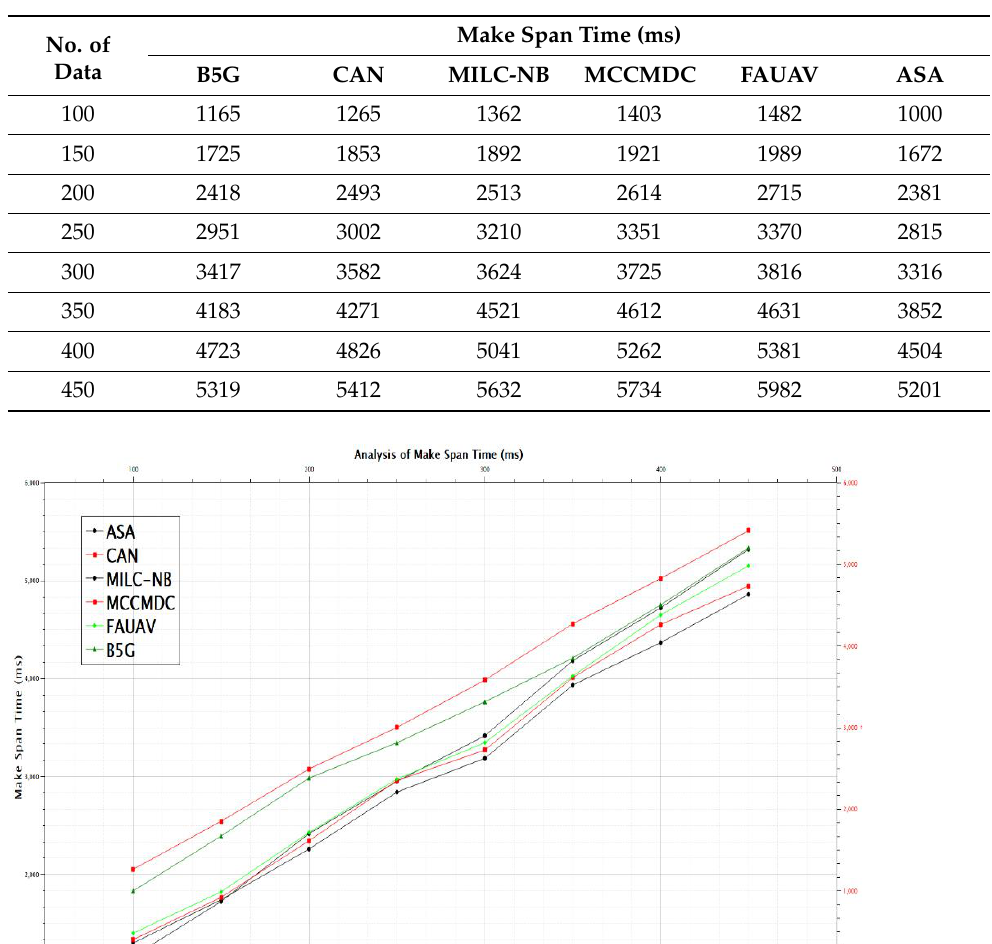
Figure 10. The total throughput after Cryptosystem Assumption. From Table 5, results in Analysis (Figure 11a – f) of Energy Consumption Before Cryptosystem Assumption show that the proposed method in Cryptosystem Assumption increases the Total packet delivered by about 79.25%, 84.25%, 87.88%, 93.00%, 97.25%, and 98.38% in comparison to MILC-NB, MCCMDC, FAUAV, CAN and B5G algorithm